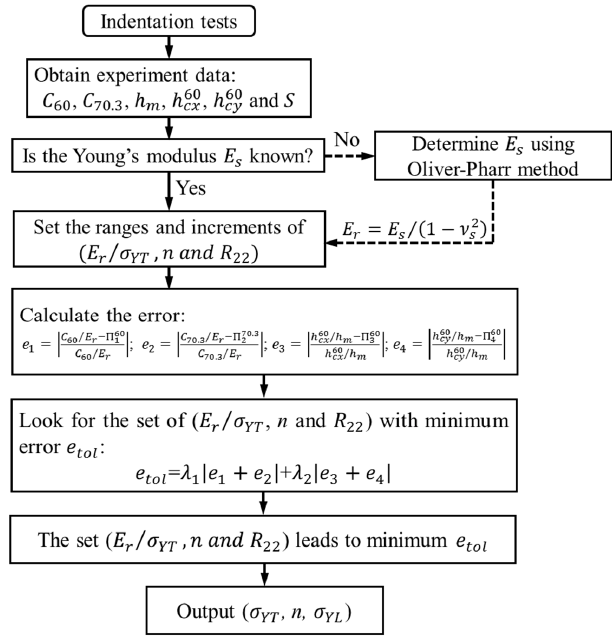
Figure 9. Flow diagram for calculating the unknown anisotropic plasticity parameters using indentation and inverse analysis.